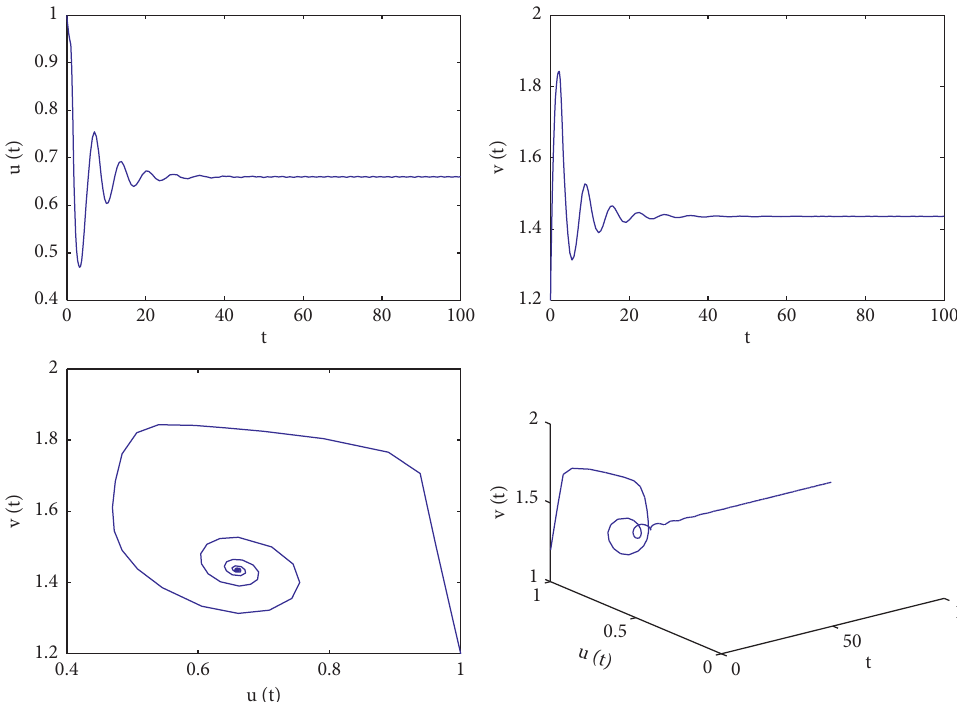
Figure 1: The trajectories graphs and phase graphs of system (93) with τ